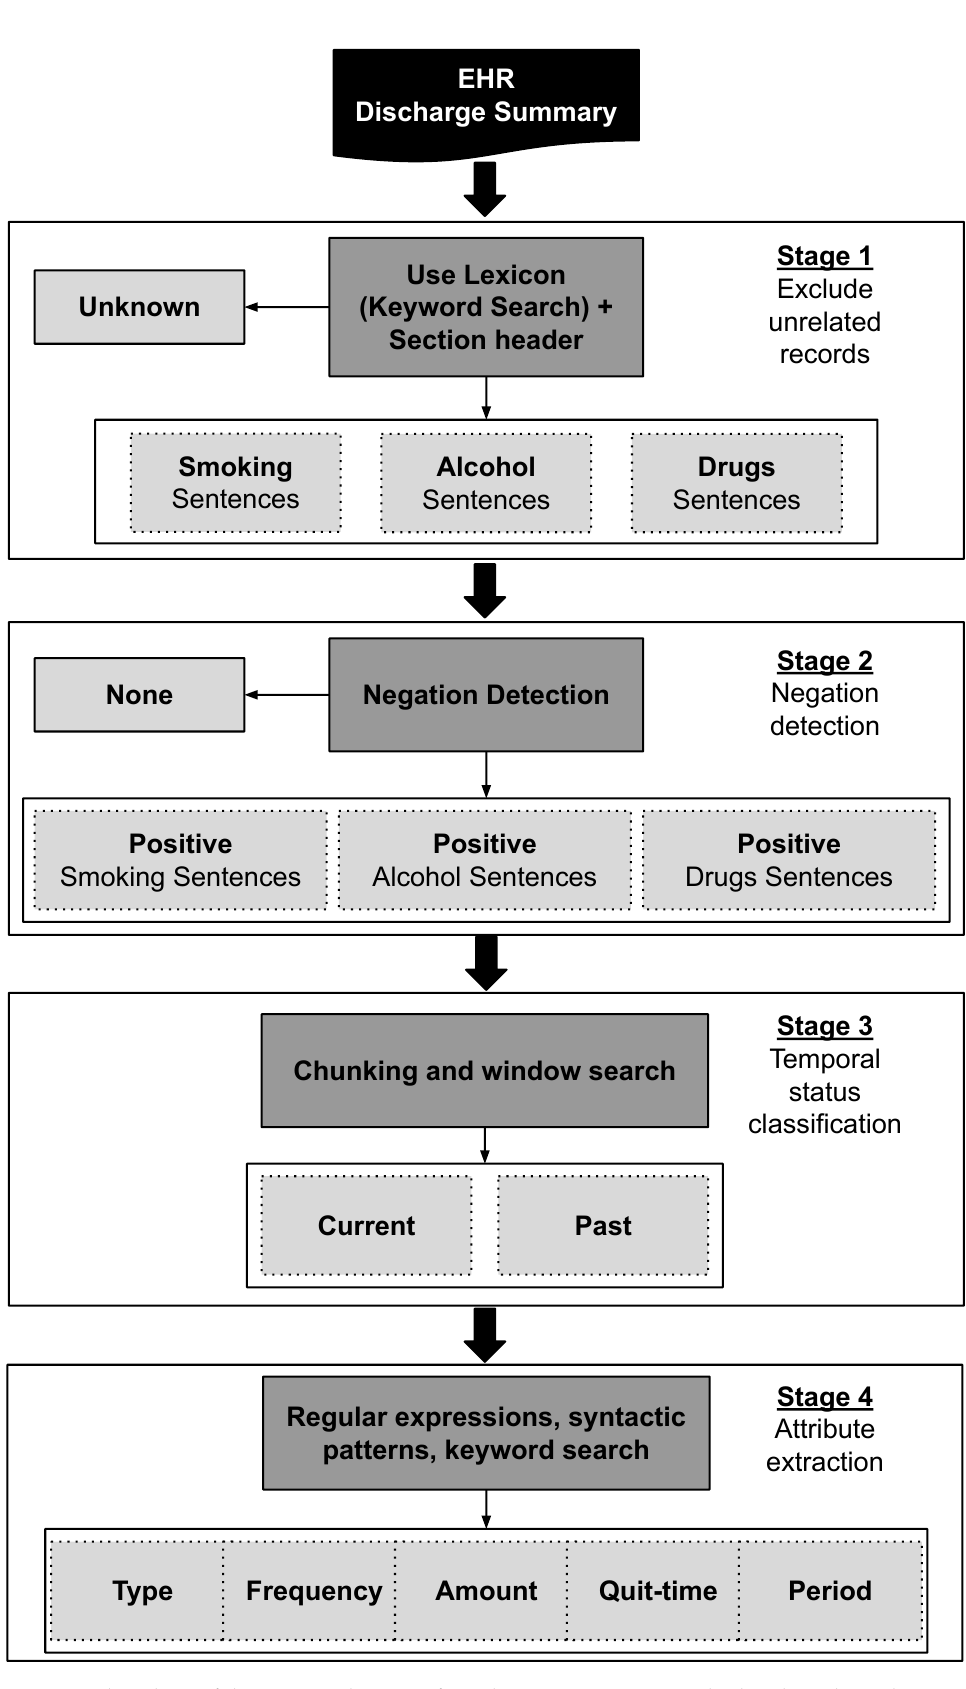
Figure 2. Flowchart of the proposed system for substance-use status and related attribute